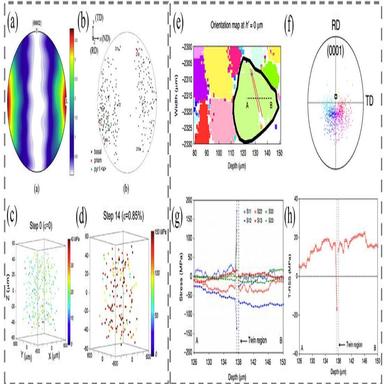
Orientation mapping and stress distribution of slip activity and twinning: (a, b) pole figure; (c, d) centers of mass and von mises stress ; (e) orientation map; (f) basal pole figure for all the voxels; (g) distribution of stress and strain components; (h) twin-plane resolved shear stress distribution .